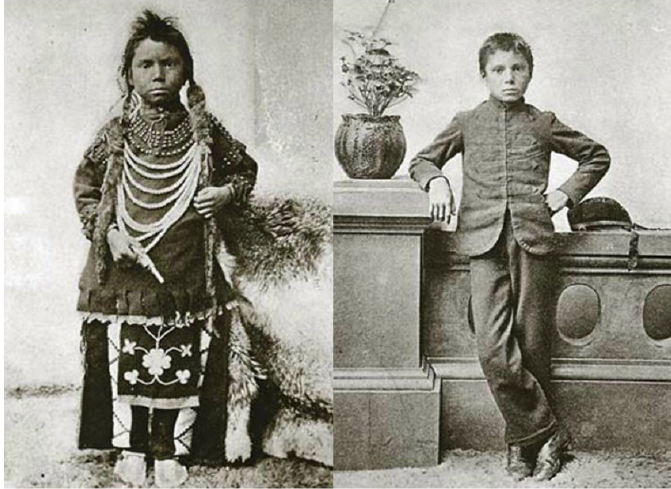
Figure 2. Thomas Moore before and after admission to Regina Indian Industrial School, ca. 1897. Saskatchewan Archives Board (R-A82223